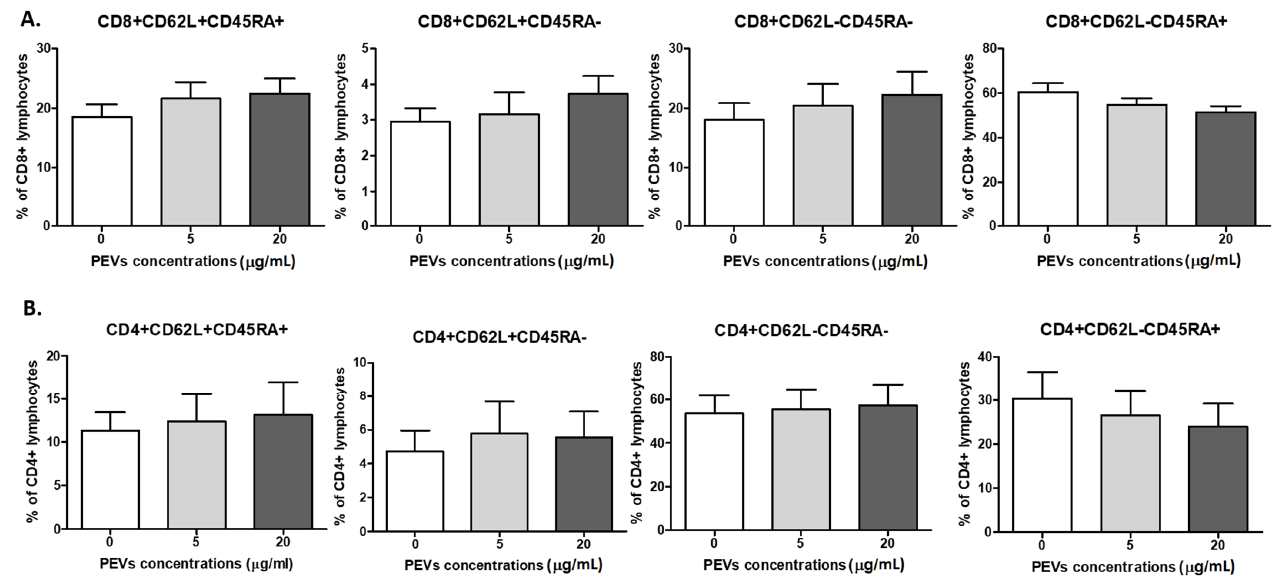
Figure 4. Changes in frequencies of canine CD8 + ( A ) and CD4 + ( B ) lymphocytes after 5 days culture of PBMCs in a 37°C, 5% CO 2 environment with ConA and IL-2 presence and PEV1/ PEV2 or without PEVs ( n = 8). The results are presented as the mean ± SEM.